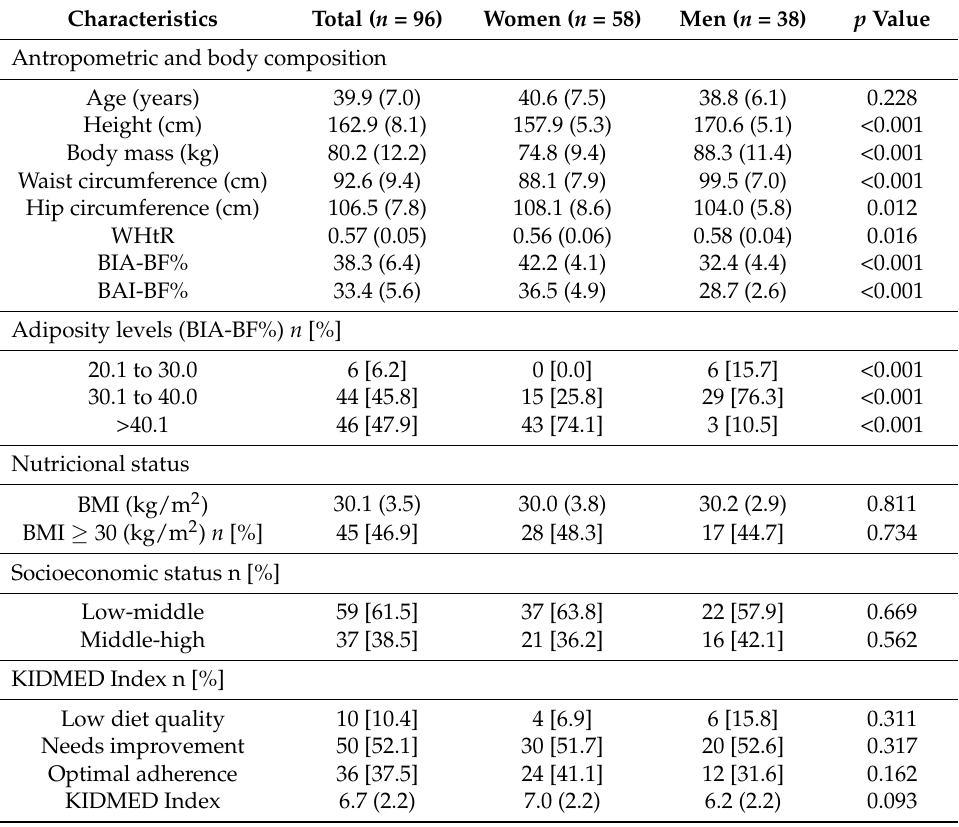
Table 1. Characteristics of study subjects as a whole and by sex ( n =